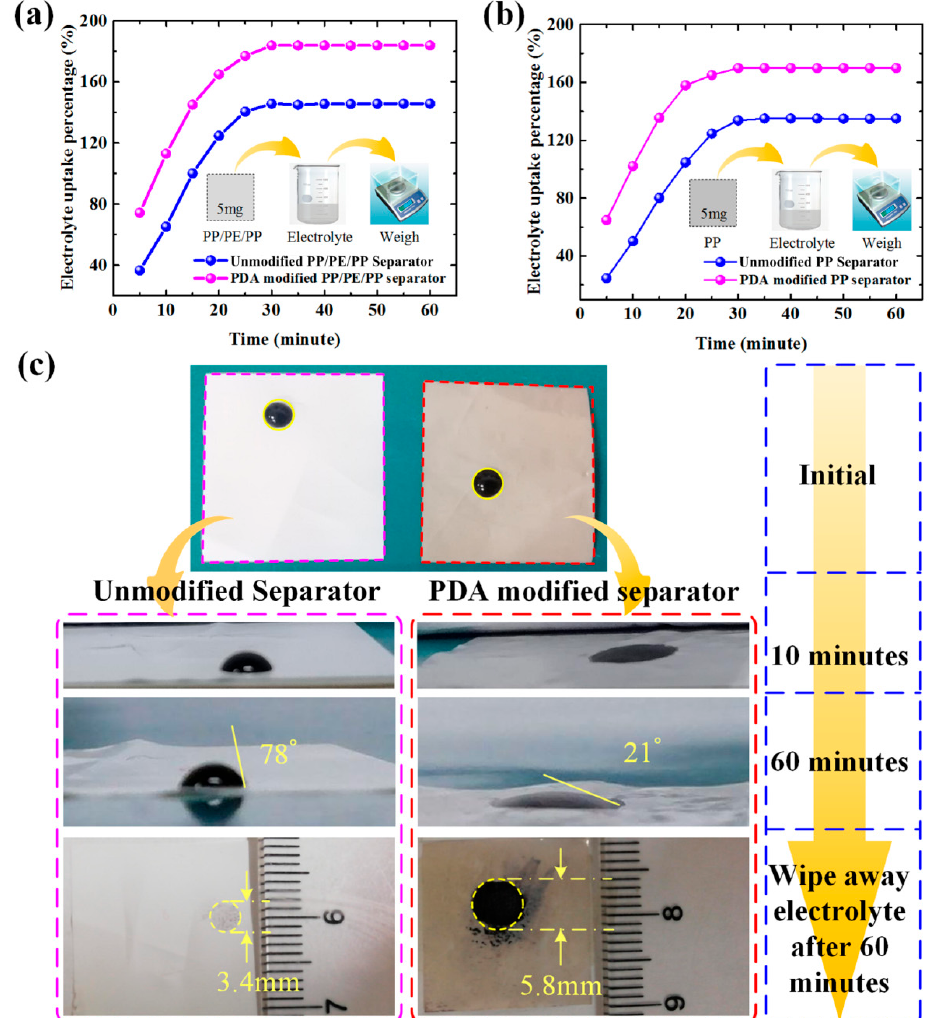
Figure 6. The changes of the electrolyte uptake percentages of separators with time: (a,b) unmodified and PDA-modified separators; (c) contact between unmodified/PDA-modified separator and colored electrolyte with time, and contact angles of unmodified and PDA-modified separators are 78° and 21°; the colored electrolyte was wiped away after 60 min and contact areas of unmodified and PDA-modified separators were 9.07 mm 2 and 26.41 mm 2 .